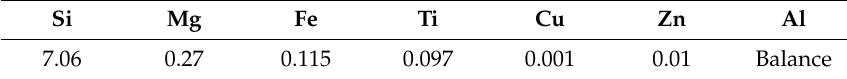
Table 1. Chemical composition of commercial A356 alloy (wt %).